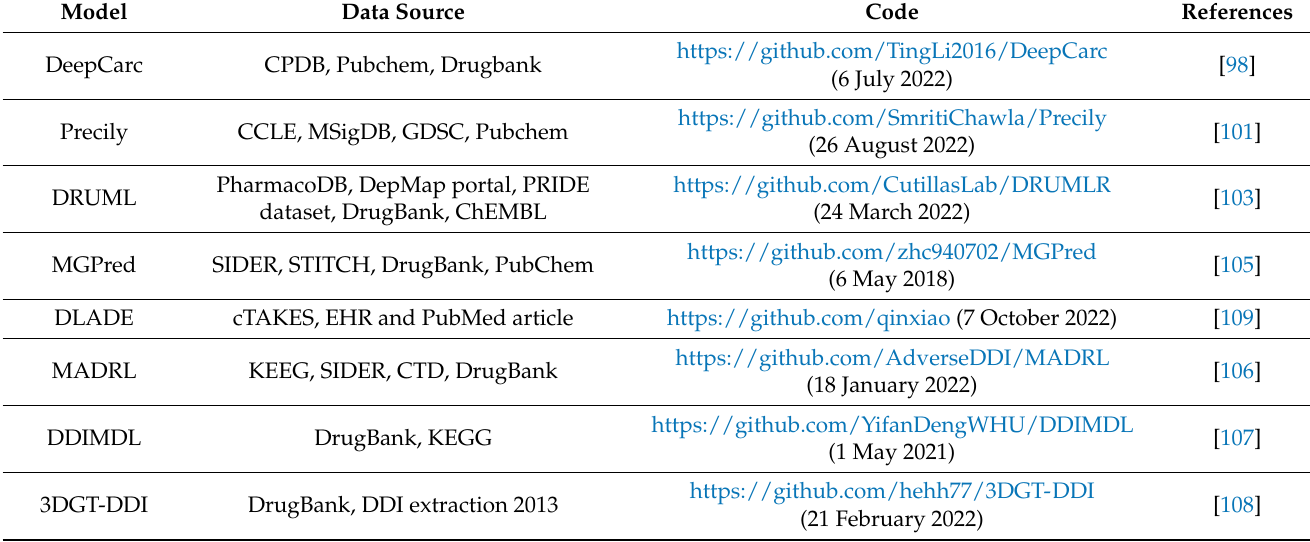
Table 6. Methods for prediction of cancer drug reactions based on artificial intelligence.